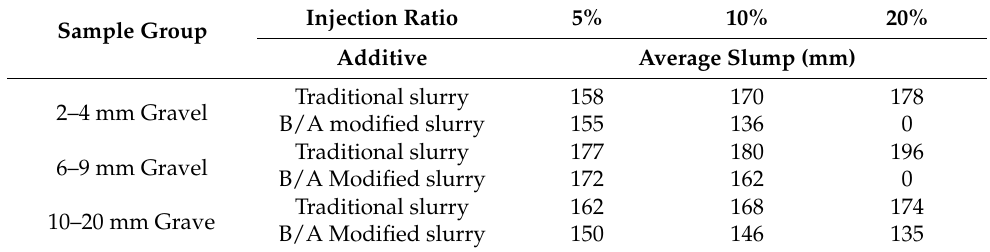
Table 7. Comparison of slump between slurry and B/A modified